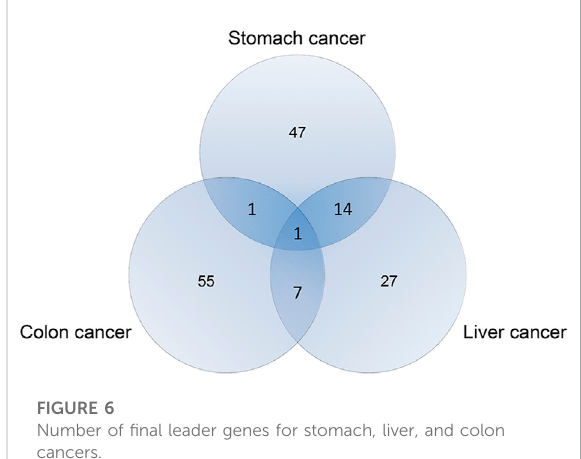
FIGURE 6 Number of fi nal leader genes for stomach, liver, and colon cancers.